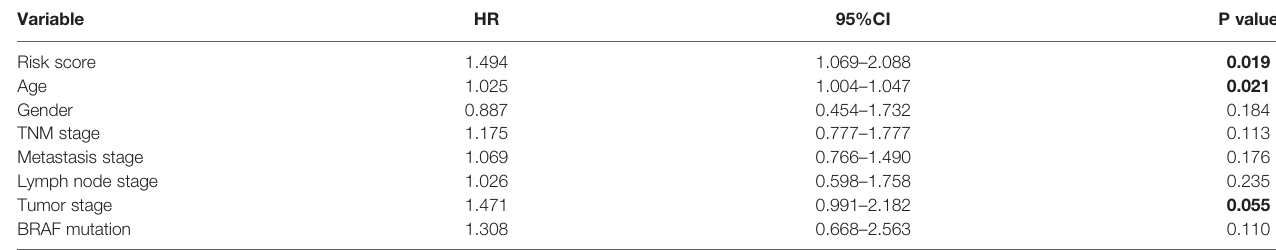
Bold values indicate that the P value is less than 0.05.